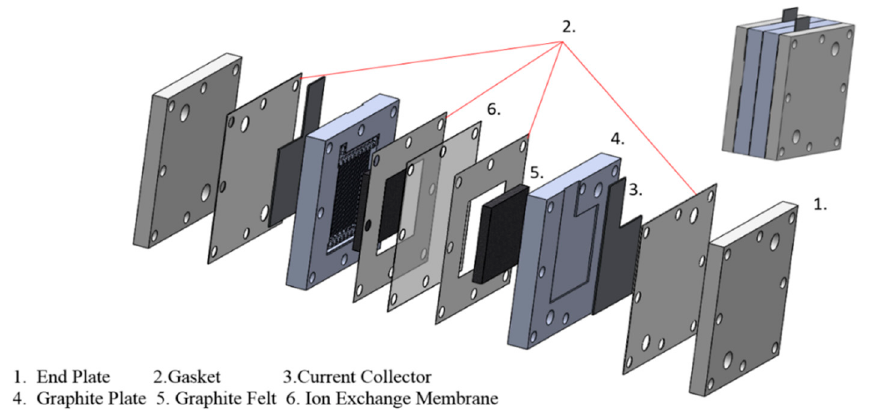
Figure 5. Compositions of the vanadium